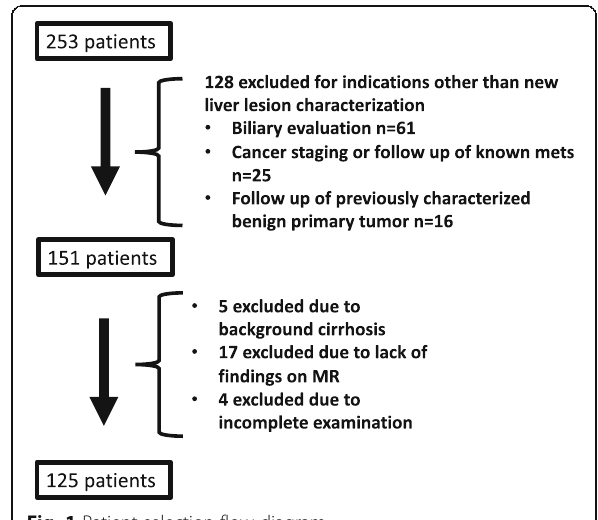
Fig. 1 Patient selection flow